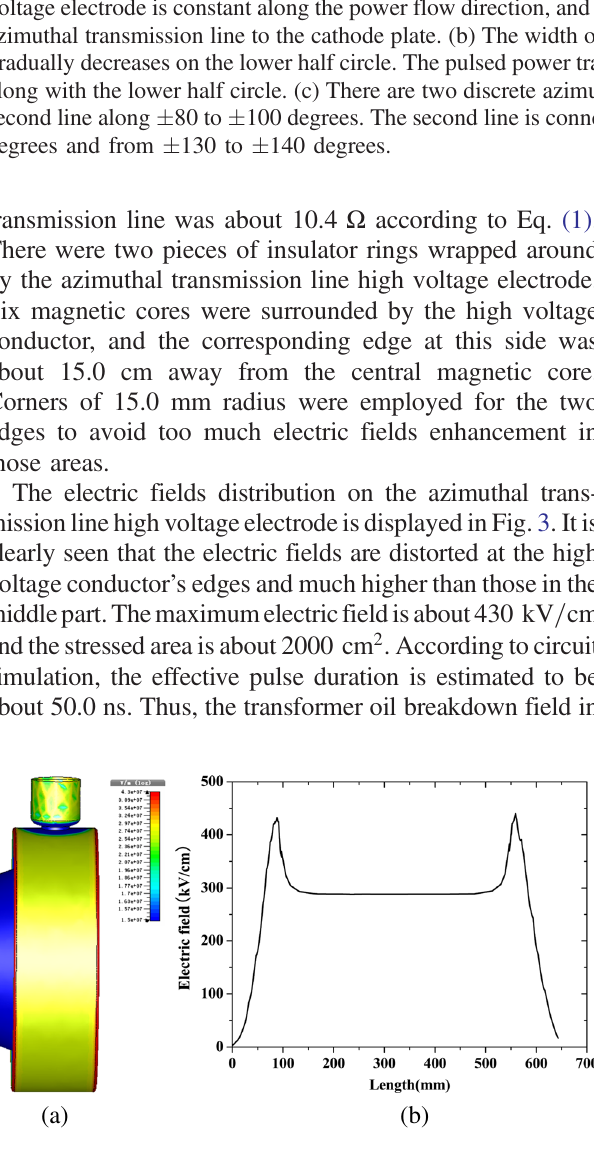
FIG. 3. Calculated electric fields on the high voltage electrode of the azimuthal transmission line which is the negative electrode; (a) electric fields contour (b) electric stresses in the 90 degrees plane.